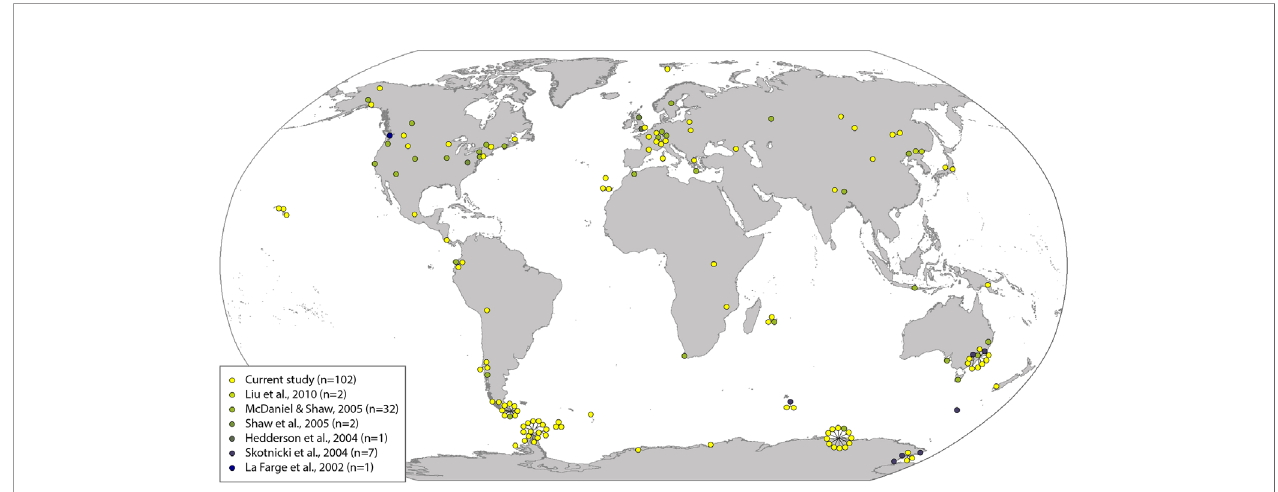
FIGURE 1 | Geographical distribution of Ceratodon purpureus samples. Colored dots refer to sequences generated in this study (yellow) and previously published studies (remaining colors; for more information see Supplementary Table S1